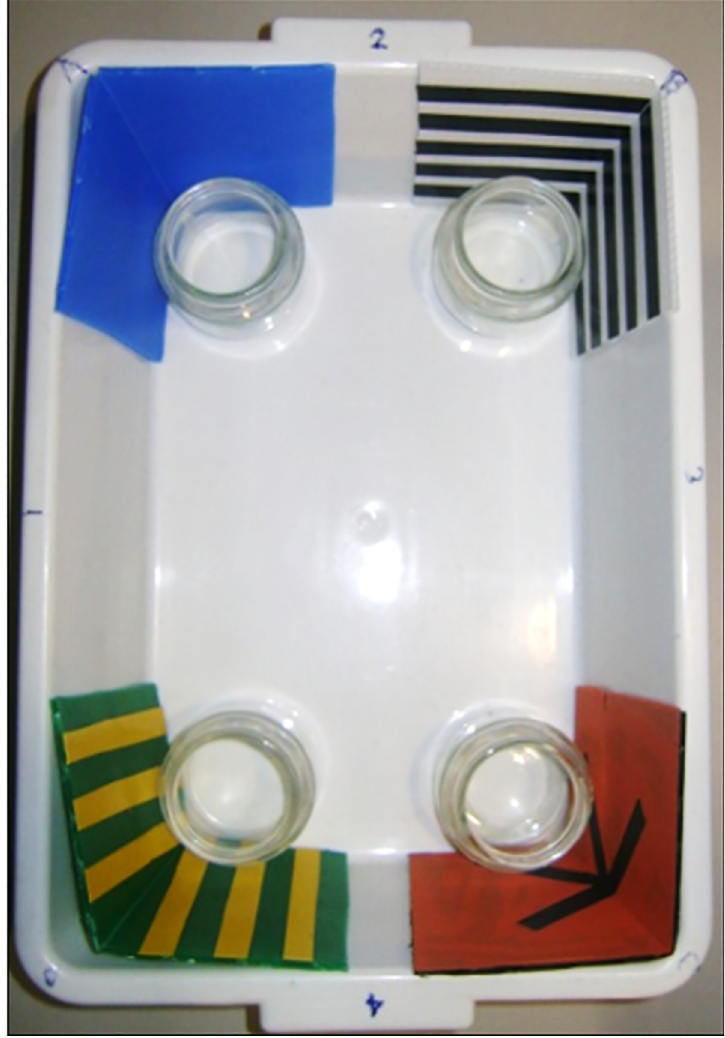
Fig 1. Rectangular experimental arena for the spontaneous memory cued task. Photograph of the rectangular tank used in the Experiment 1 with different colored panels at corners, using a spontaneous memory procedure involving a social